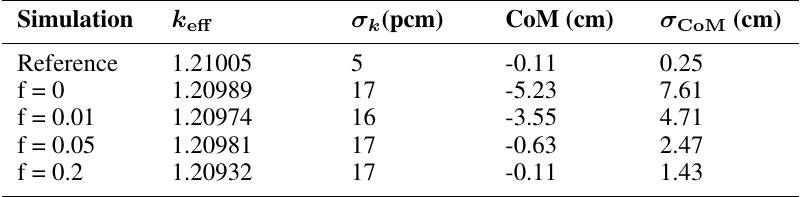
Table 1: Results for the reflective PWR